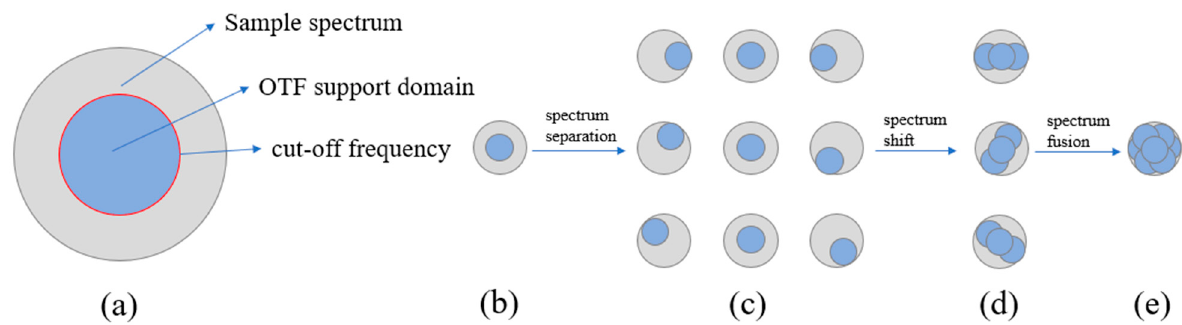
Figure 2. ( a ) frequency detection range of fluorescence microscopy systems of wide-field illumina- tion; ( b ) image spectrum acquired in wide-field illumination mode; ( c ) the 0°, 60° and 120° directions are used respectively, and the initial phase difference in each direction is 2 π /3 of the sinusoidal mode structure stripe light illumination sample. The high and low frequency spectrum components are obtained by spectrum separation of the collected images; ( d ) spectral fusion in a single direction can achieve image super-resolution in a single direction; ( e ) by fusing the high and low frequency spectrum in each direction, the super-resolution image of the two-dimensional plane can be ob- tained.